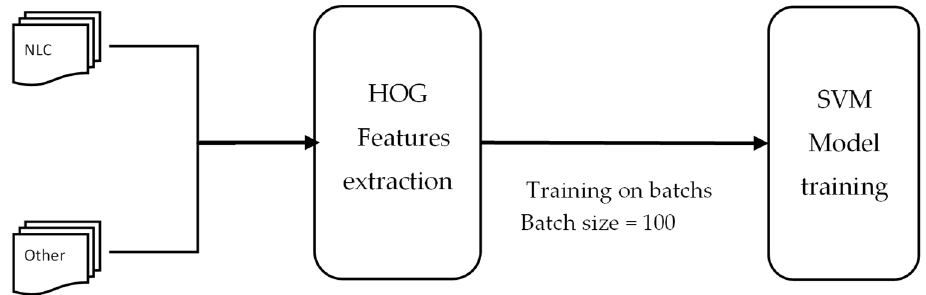
Figure 2. Process of training of SVM model with HOG (histogram of oriented gradient) features.